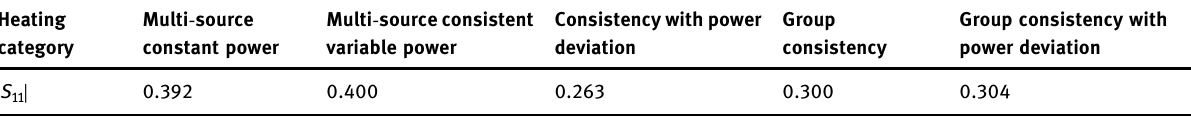
Table 5: Di ff erent heating models | S 11